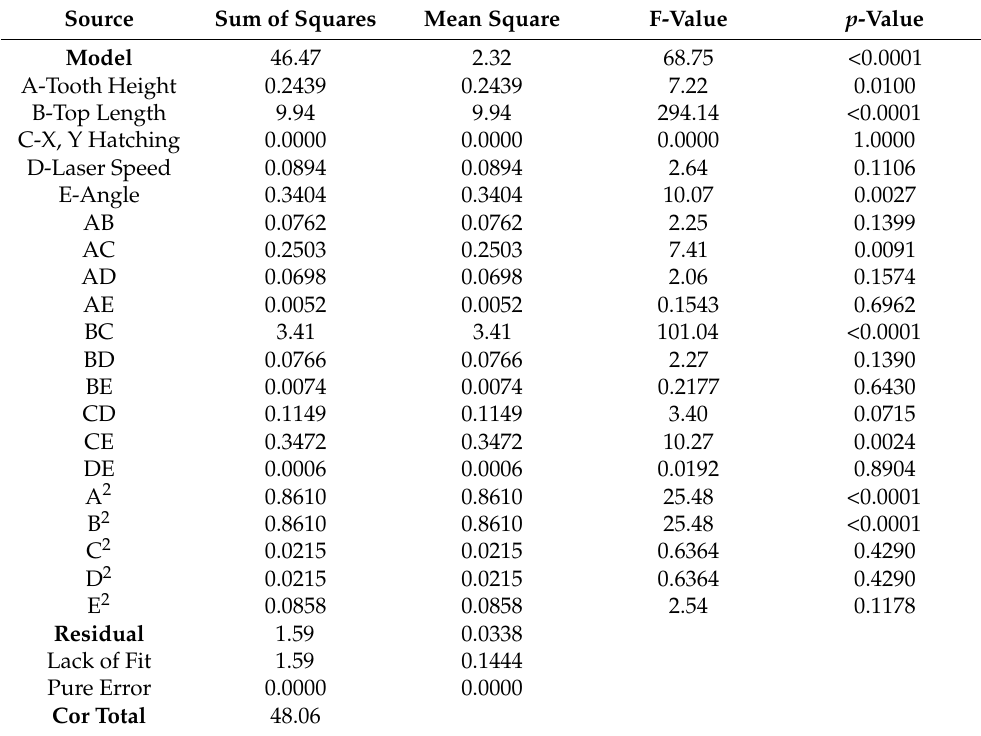
Table 6. ANOVA results for the quadratic model of Support Removal